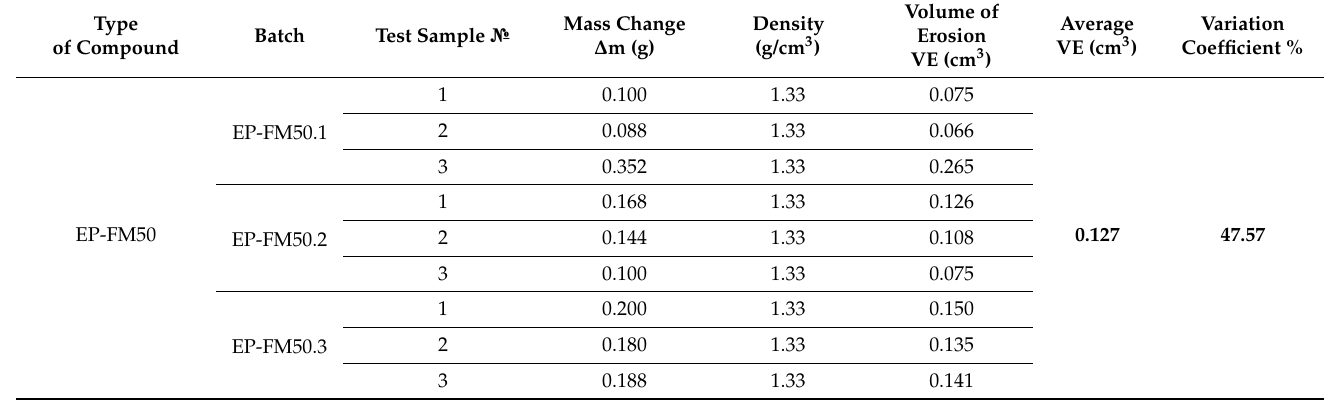
Table A21. Wear of filled epoxy binder (EP-FM50) at 100 ◦ C at an impingement angle of 90 ◦